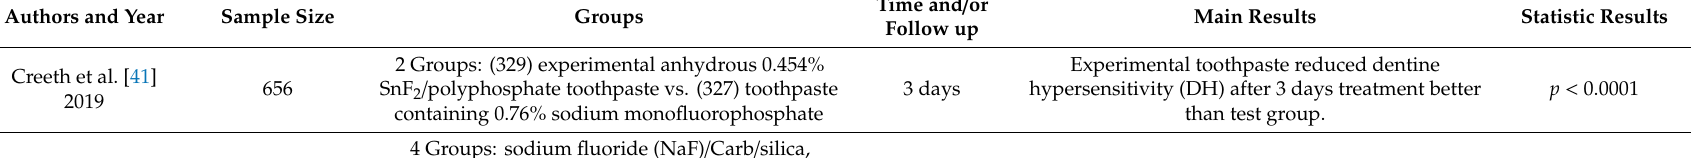
Group 1 showed better results on plaque regrowth compared to alcohol-free essential oil mouthwash. But there was a less impact if compared to CHX.